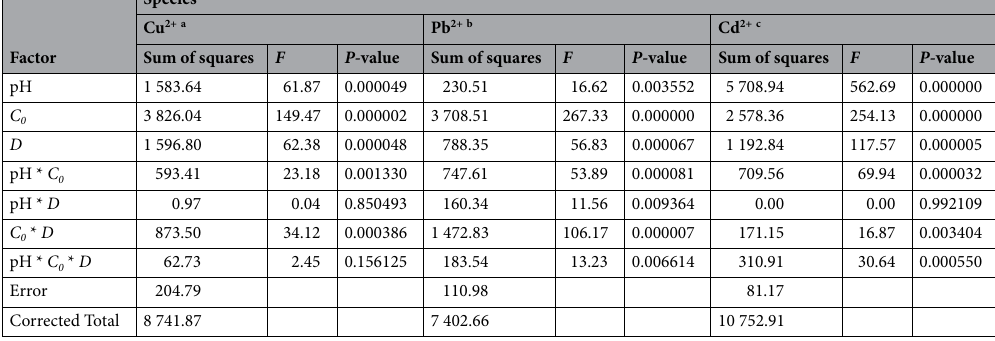
Table 5. Analysis of variance-full model fitting for removal efficiency. a R 2 = 0.98 (Adjusted R 2 = 0.96).